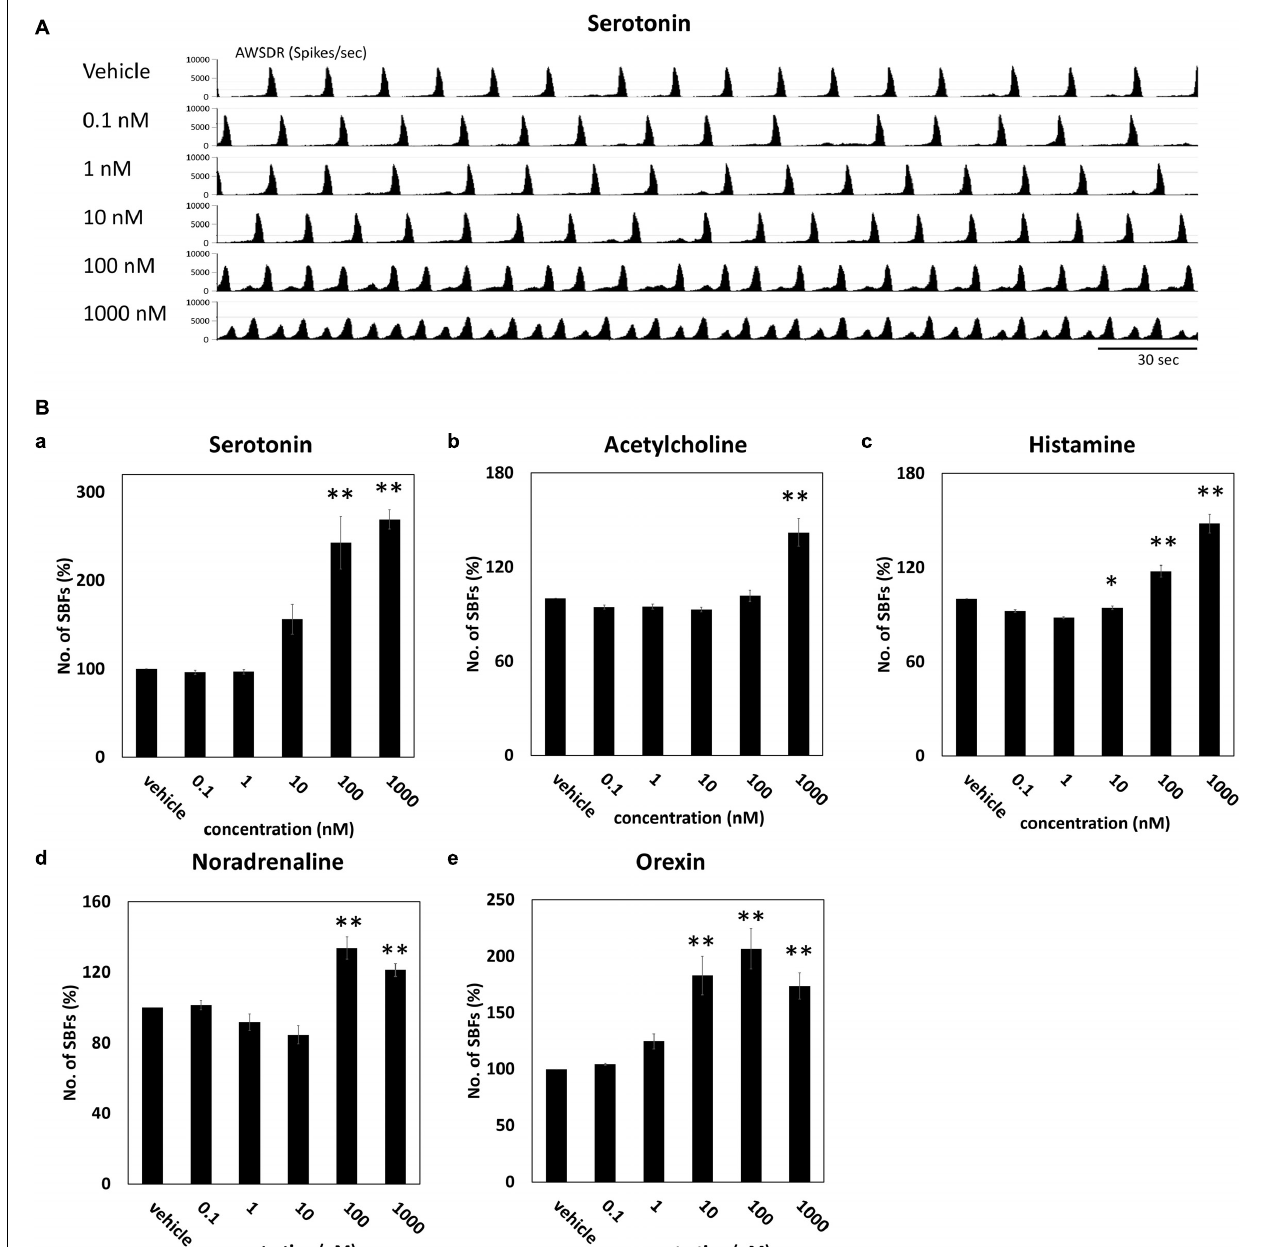
FIGURE 3 | Neurotransmitter induced an increase of SBFs in human iPSC-derived dopaminergic neurons. Neurotransmitters were added to the culture medium at increasing concentrations (0.1, 1, 10, 100, and 1000 µ M). Spontaneous firings were measured for 10 min before and after medication administration. (A) Typical array-wide spike detection rate of spontaneous firings for 5 min vehicle and serotonin administration. Scale bars = 30 s. (B) Changes in the number of SBFs versus vehicle (%) ( n = 4 wells, One-way ANOVA and Holm test, ∗ p < 0.05, ∗∗ p < 0.01 vs. vehicle). (a) Serotonin. (b) Acetylcholine. (c) Histamine. (d) Noradrenaline. (e)